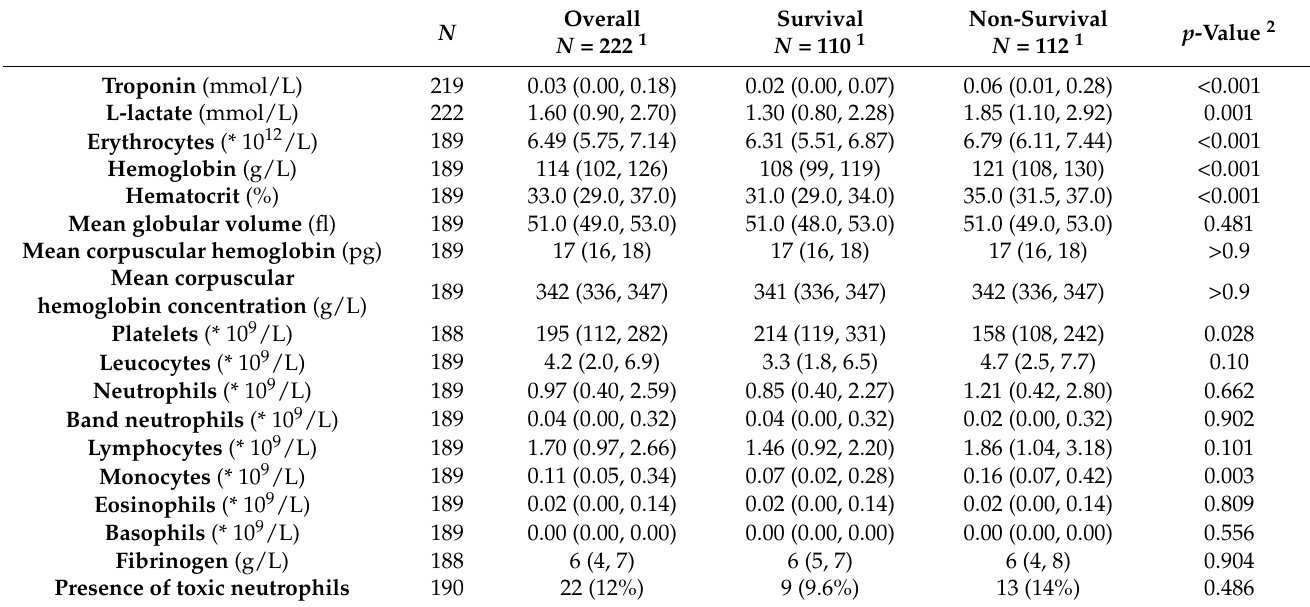
Table 2. Descriptive statistics (overall and stratified by survival status) of complete blood count, cardiac troponin 1, and L-lactate measurement data from dairy cows (124 herds) affected by severe clinical mastitis in Qu é bec, Canada. N